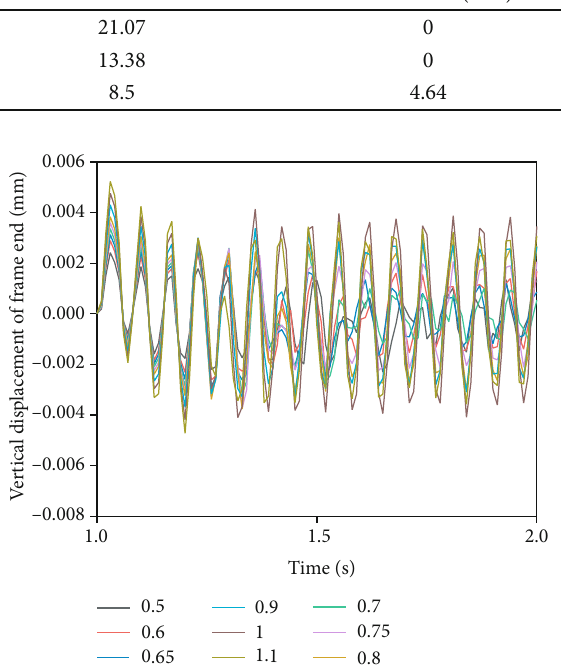
Figure 8: Vertical displacement of the frame end under di ff erent ejection